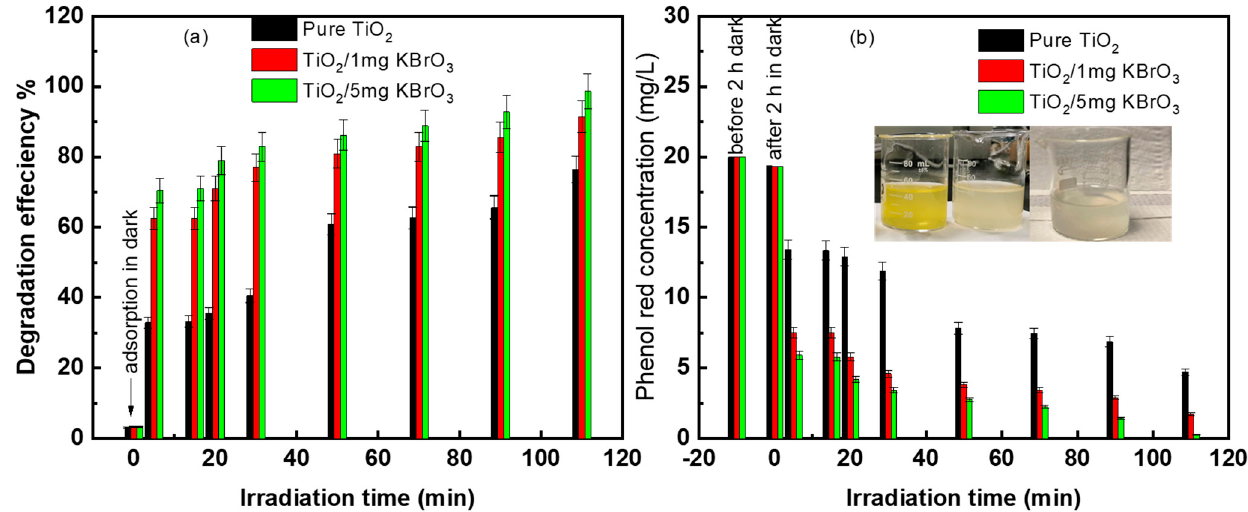
Figure 6. ( a ) Photocatalytic efficiencies, and ( b ) phenol red concentration of TiO 2 , TiO 2 @ 1 mg-KBrO 3 , and TiO 2 @5 mg KBrO 3 samples.